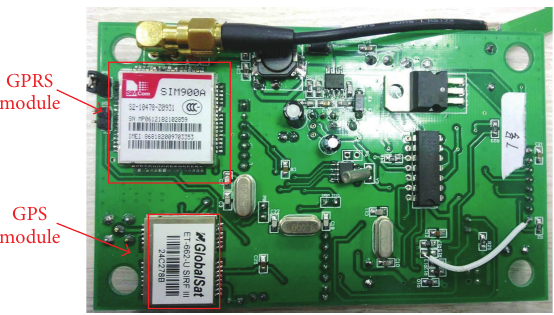
Figure 4: The reverse side view of the terminal.